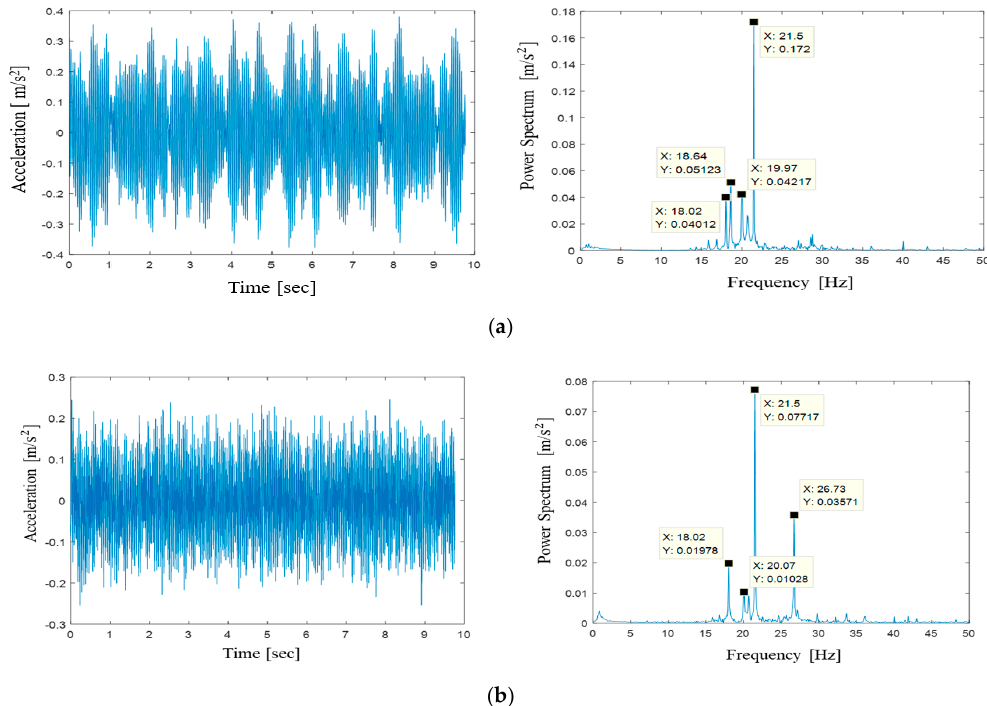
Figure 8. Vibration responses under multiple operations of entire facilities; ( a ) Vibration response after adjusting operating speed at the shipping control center; ( b ) Vibration response after adjusting operating speed at the plant office floor.